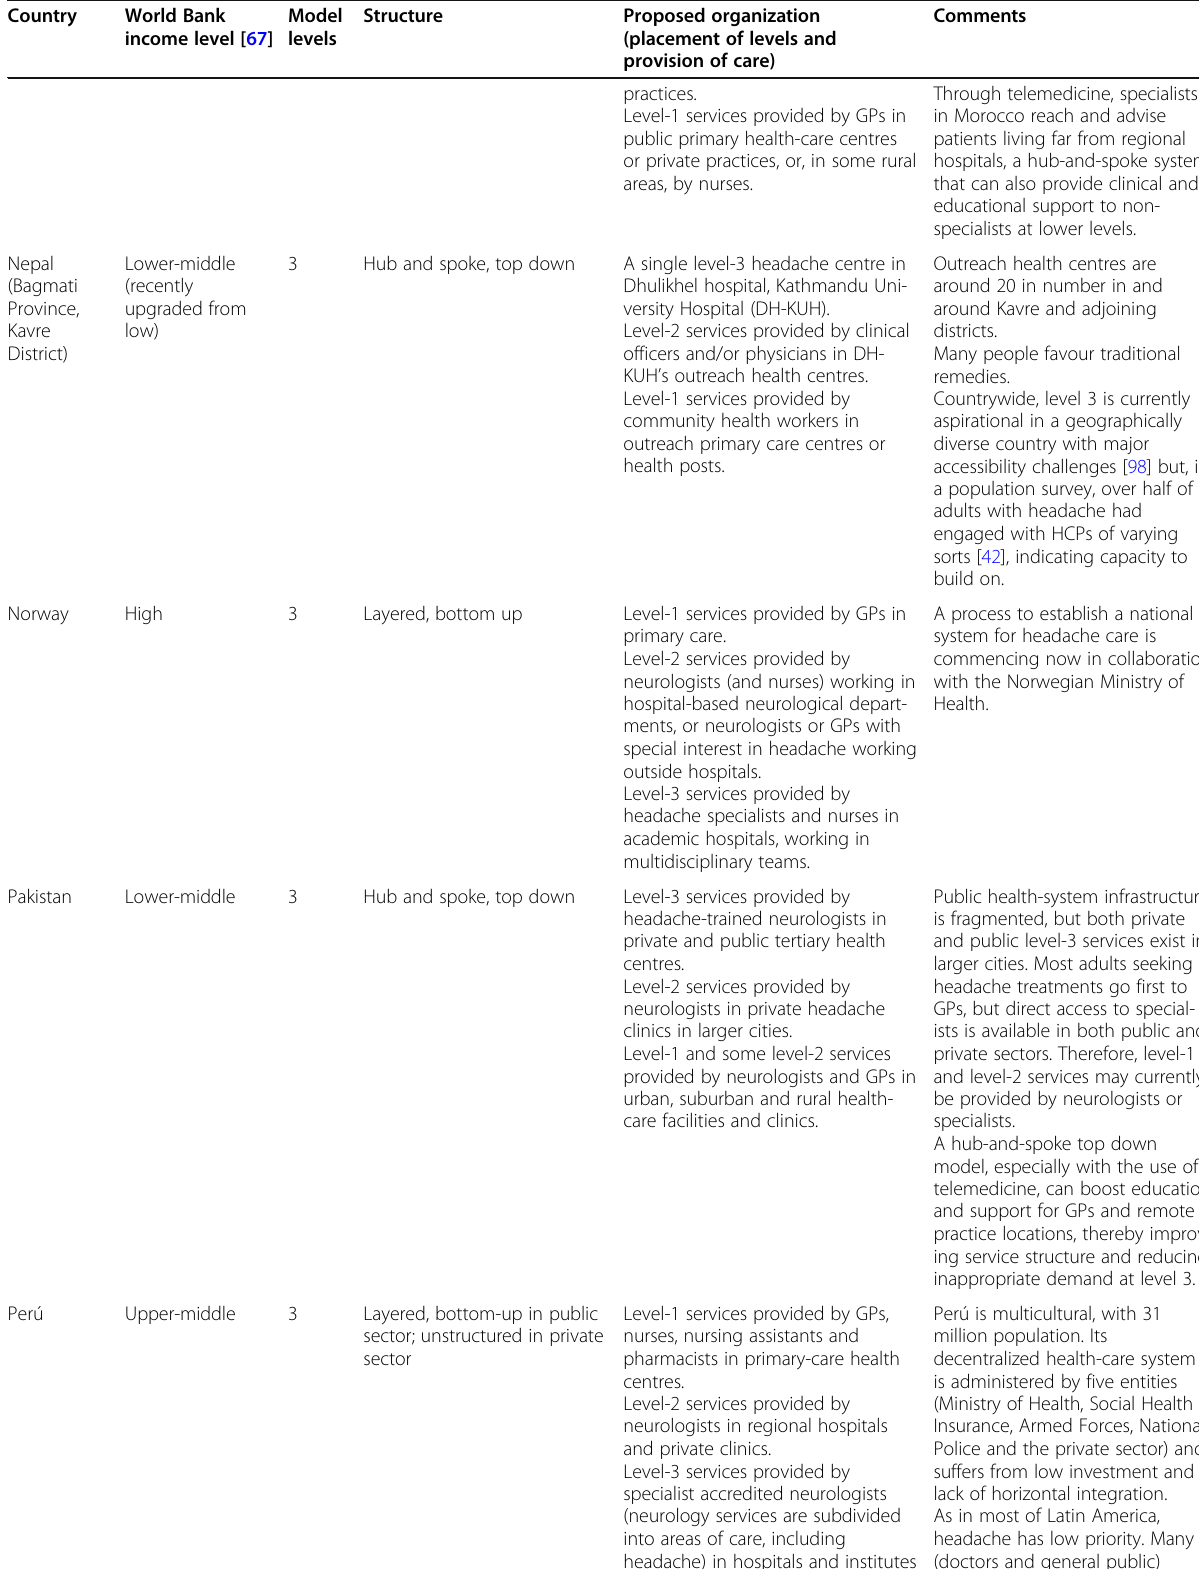
Table 7 Illustrations of how the model might be implemented, with adaptations, in various countries